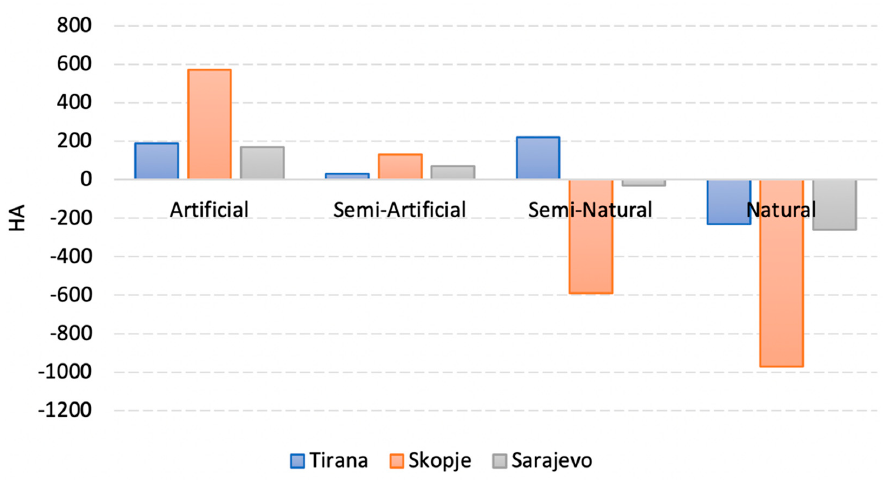
Figure 6. Statistical analysis, comparing each city’s urban and peri-urban differences (ha) in 2018–2012, according to the re-classification into four categories.